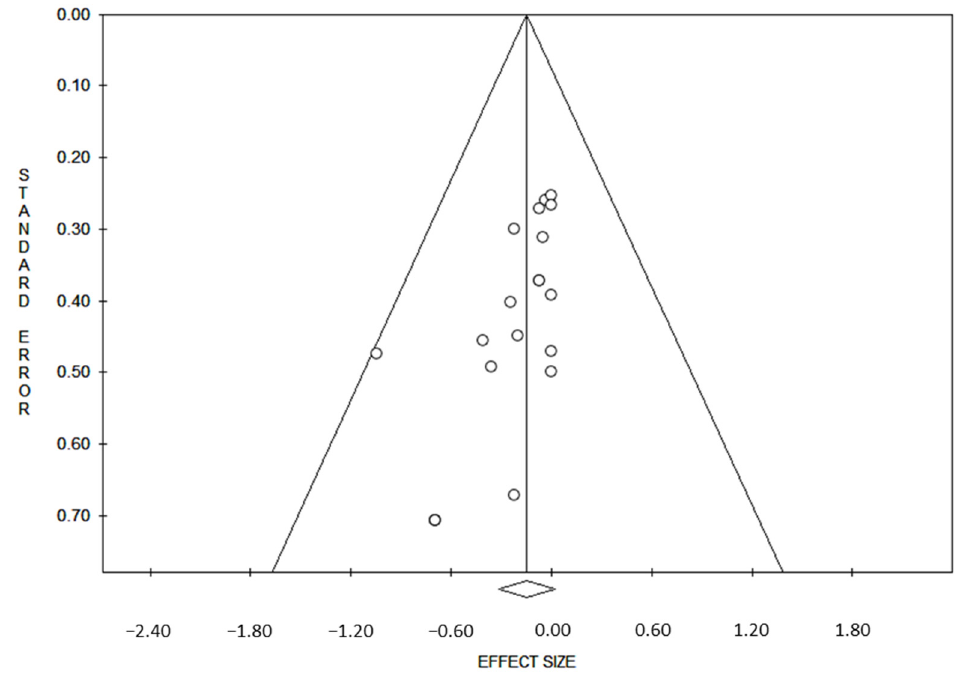
Figure 1. Symmetric funnel plot consistent with lower likelihood of publication bias. The x-axis indicates DOG1 expression and the y-axis is the standard error.